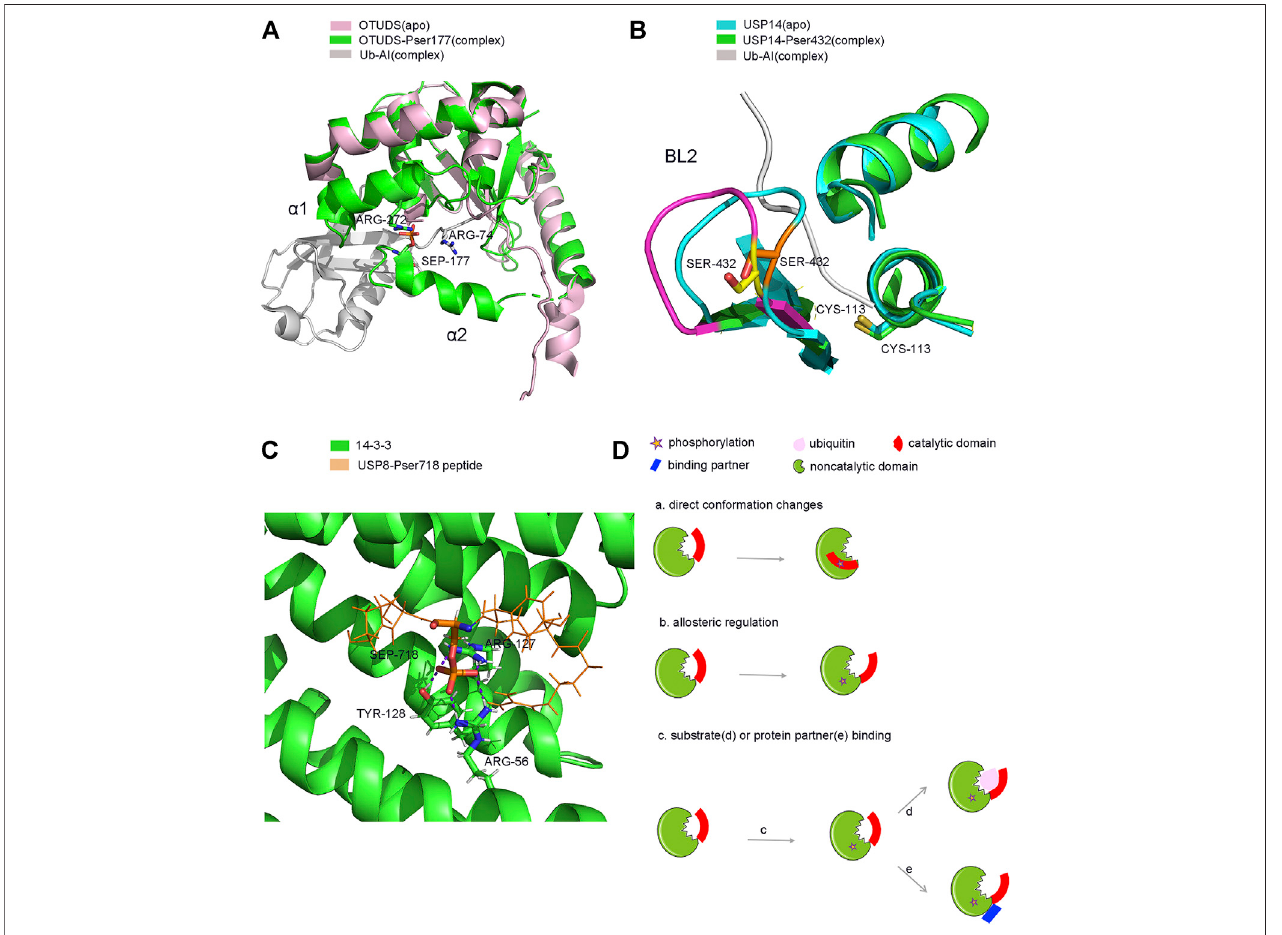
FIGURE 4 | Structure and model of PTMs-induced conformation changes of DUBs. (A) . Phosphorylation induced conformation changes of OTUD5 after Ub binding. (B) . Phosphorylation induced direct conformation changes of USP14 (C) . Phosphorylation induced partner binding of USP8. (D) . Model of PTMs induced conformation changes of DUBs. (a) . phosphorylation-induced conformation changes (b) . phosphorylation-induced allosterically regulated conformation changes (c) . phosphorylation-induced substrate (d) or protein partner (e) binding and conformation